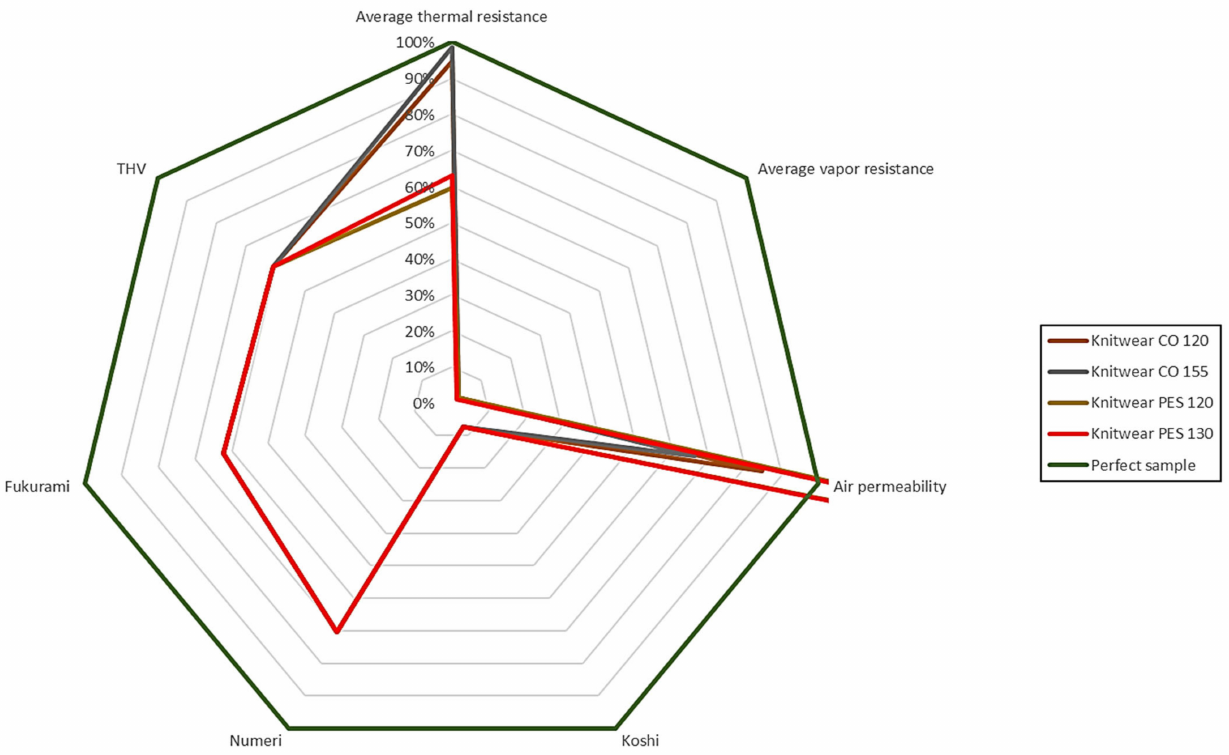
Figure 14. Sensory and biophysical properties of two-layer laminates and foils.